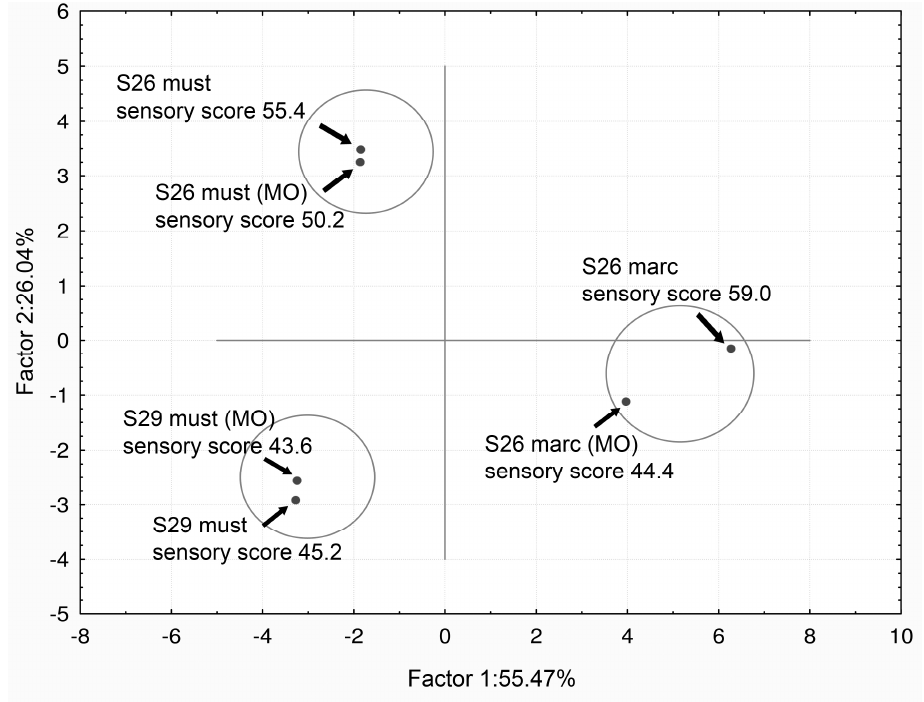
Figure 6. Bi-dimensional plot of principal component analysis (PCA) values after combining data from chemical and sensorial analysis. Projection of the data according to the strains and the deacidification process. Adapted from Vilela-Moura et al. [56].